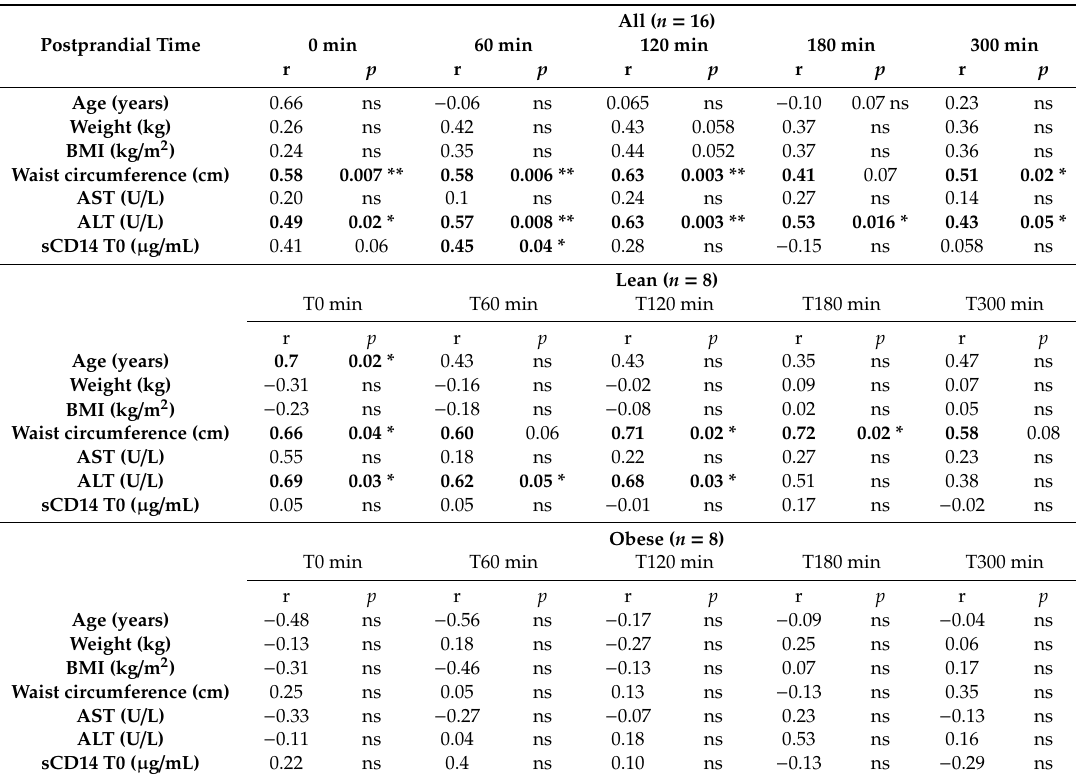
Table 2. Correlation analyses (Spearman) with postprandial plasma LBP concentrations as dependent